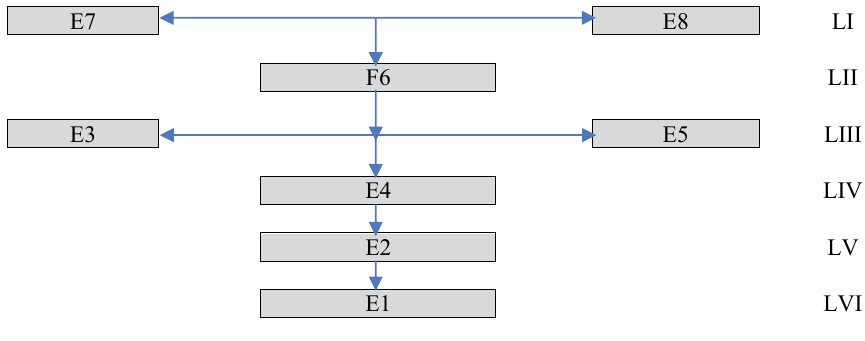
Fig. 2. ISM for Enablers of GSCM on Construction